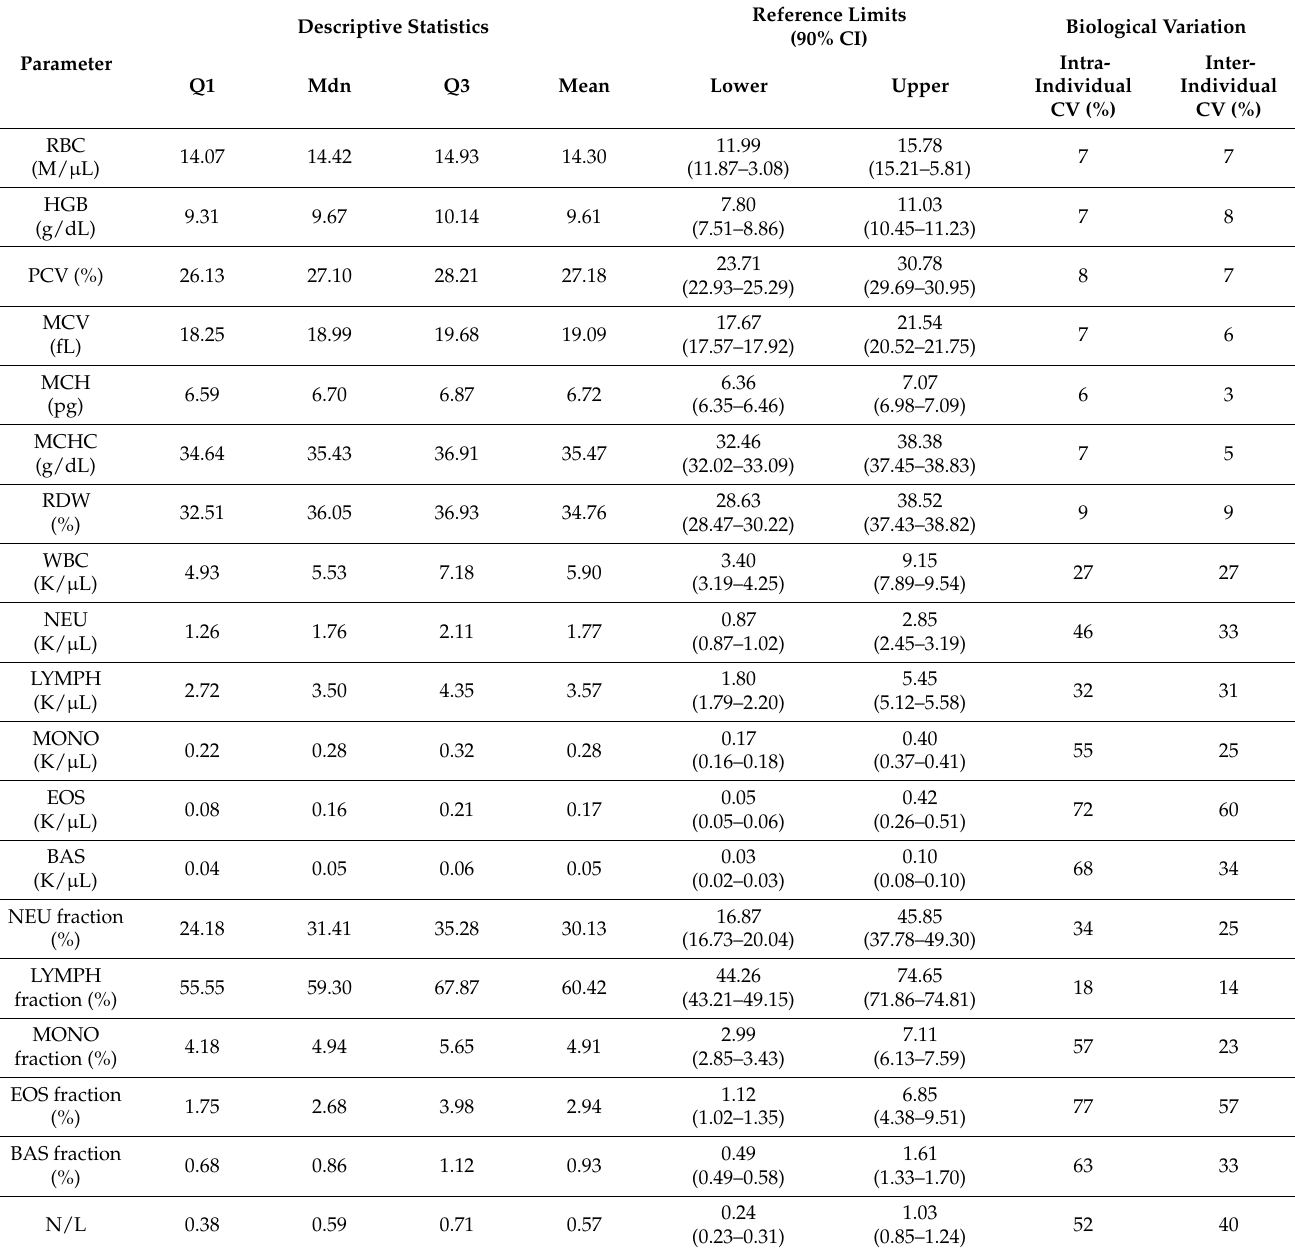
Table 2. Descriptive statistics, reference limits, and biological variation for hematological variables in Verzaschese